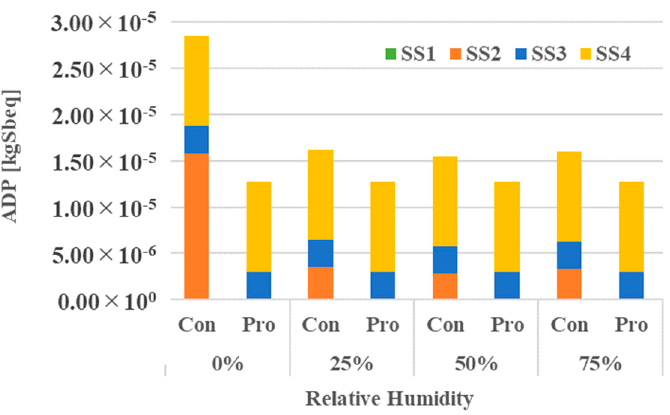
Figure 13. ADP results in the sensitivity analysis.